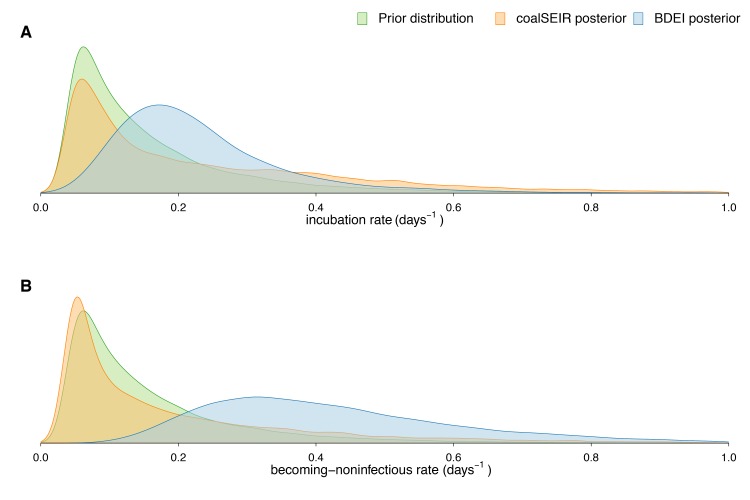
(A) Incubation rate and (B) becoming-noninfectious rate (inverse of time). We only show the posterior distributions for coalSEIR and BDEI with a constant reproductive number.